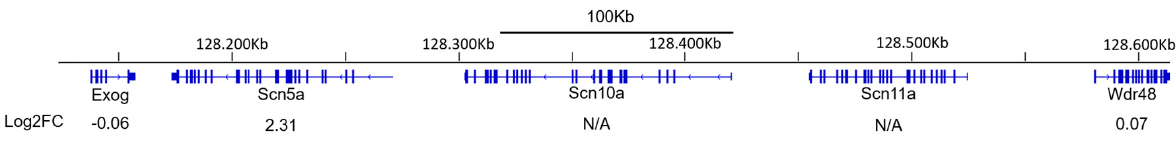
Scn5a is included, and changes in the expression of genes located within the TAD are shown as log2FC.